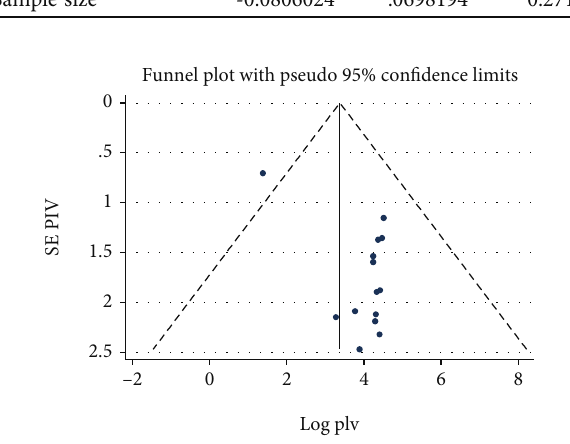
Figure 5: Funnel plot to test the publication bias in 14 studies with 95% con fi dence